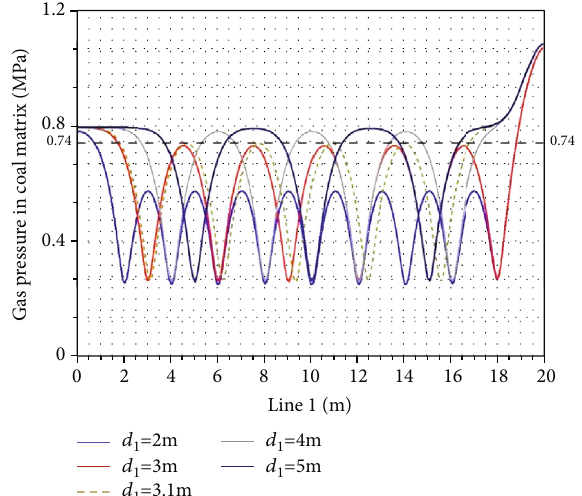
Figure 3: Distribution trend of gas pressure in coal matrix on monitoring line under di ff erent slot spacing d 1 .